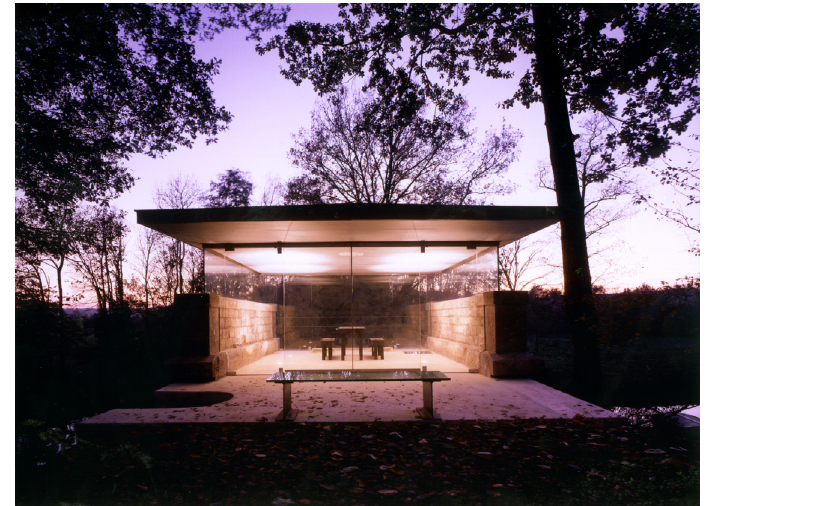
Figure 1: The Burgundy all glass walls pavilion, see